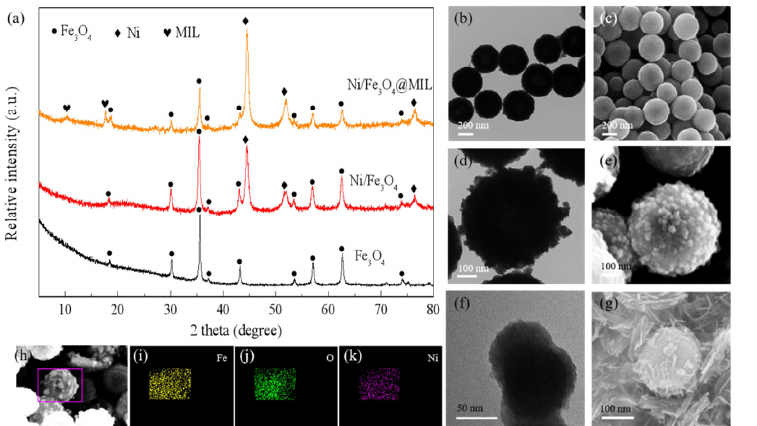
Figure 8. ( a ) XRD patterns of the Fe 3 O 4 , Ni/Fe 3 O 4 and Ni/Fe 3 O 4 @MIL. TEM and SEM images of Fe 3 O 4 ( b , c ), Ni/Fe 3 O 4 ( d , e ) and Ni/Fe 3 O 4 @MIL ( f , g ). EDS mapping of the elemental distribution of ( i ) Fe, ( j ) O and ( k ) Ni corresponding to ( h ) Ni/Fe 3 O 4 . Copyright 2022, Elsevier. Reproduced with permission from [92].